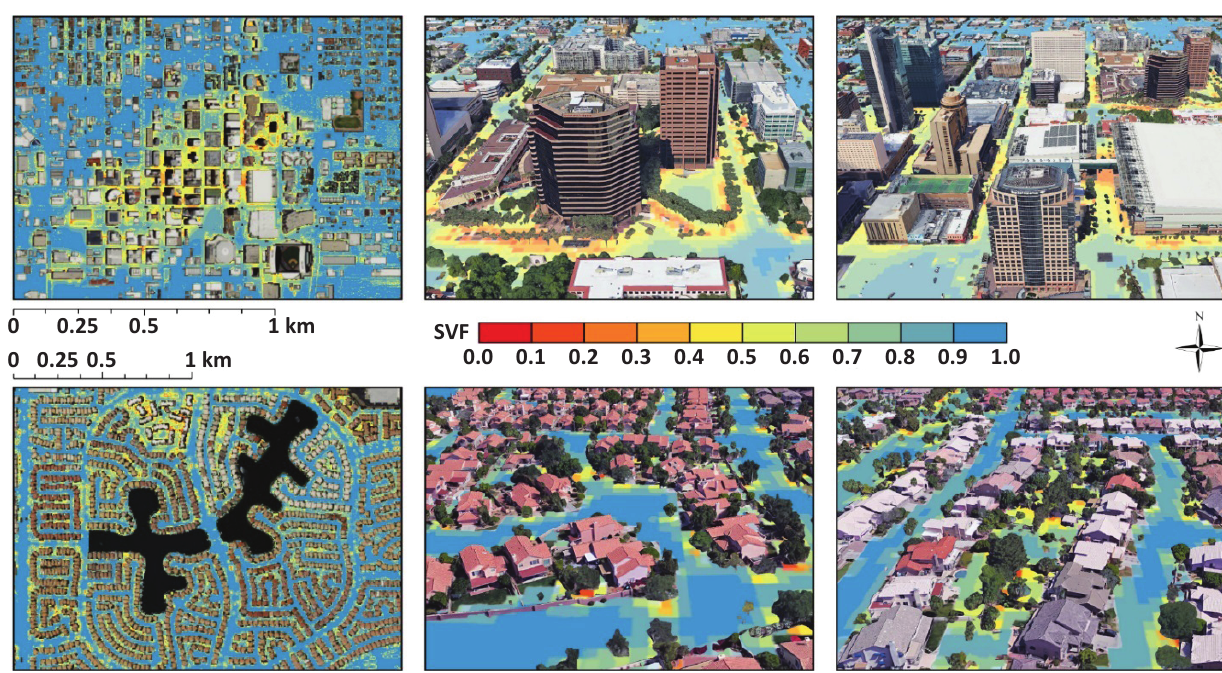
Figure 4. High-resolution Sky View Factor maps (1.1 m height) for Phoenix Downtown, Arizona, USA (top) and a residential subdivision in Phoenix, Arizona, USA (bottom) superimposed on Google Earth 3D terrain; bird’s eye view and two tilted close-up views.